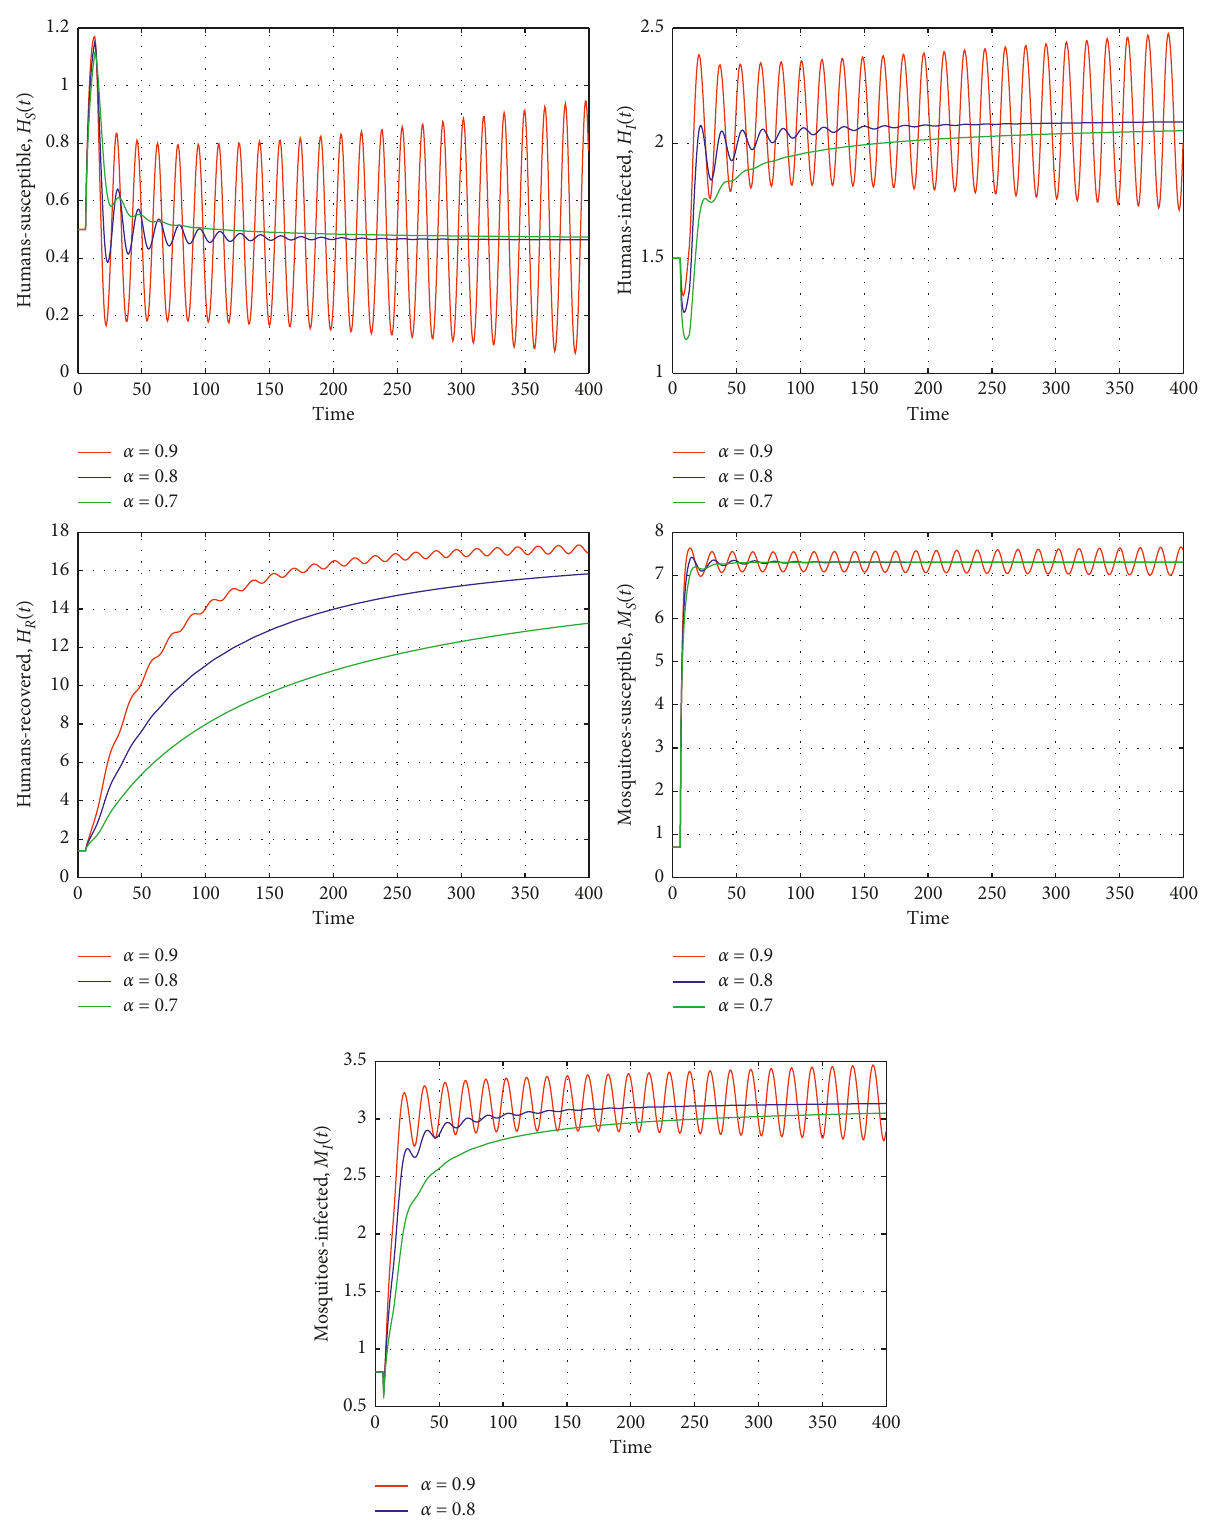
Figure 2: State trajectories for model (5) with α � 0 . 9 , 0 . 8 , and 0 . 7 and τ equilibrium point is unstable (red trajectory) for (5); however, for τ